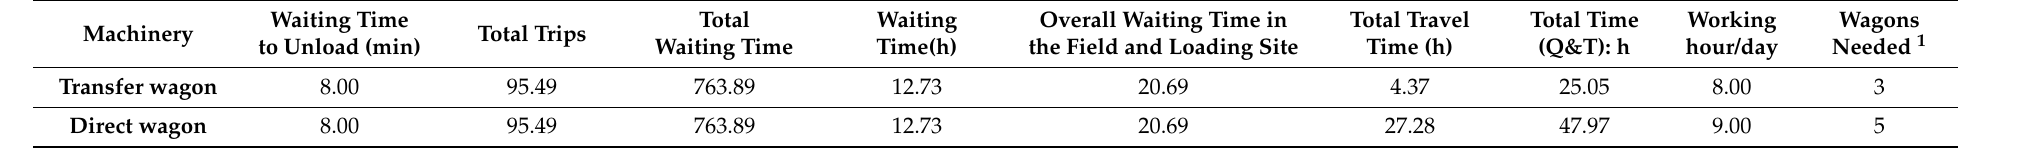
Table 3. Estimated number of wagons for transportation of harvested biomass.